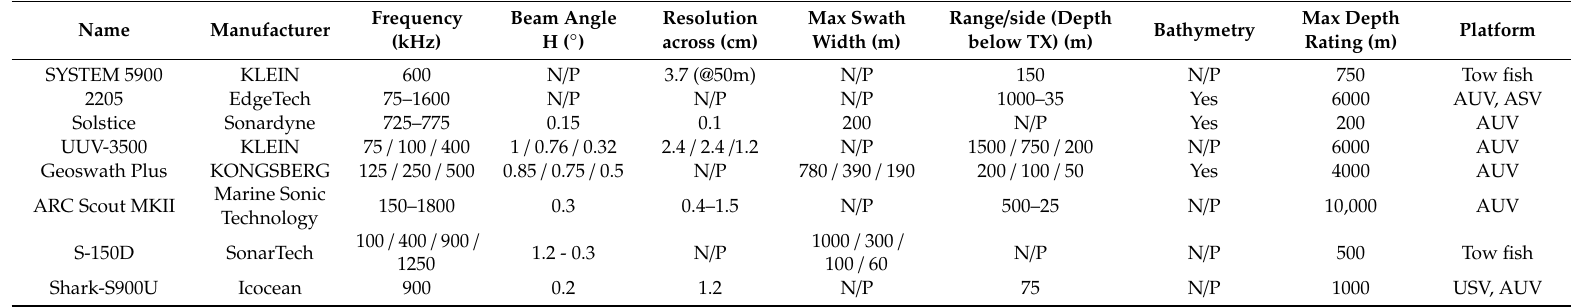
Table 7. Acoustic sensor: side-scan sonar (SSS).